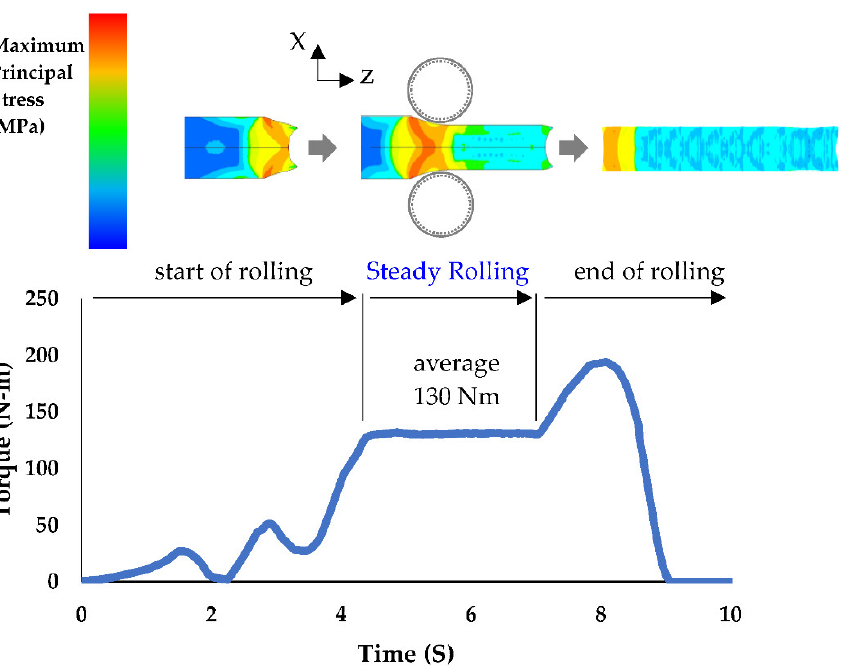
Figure 5. The history of rolling torque and the maximum principal stress distribution for the first stand using a Bézier curve groove-shape.